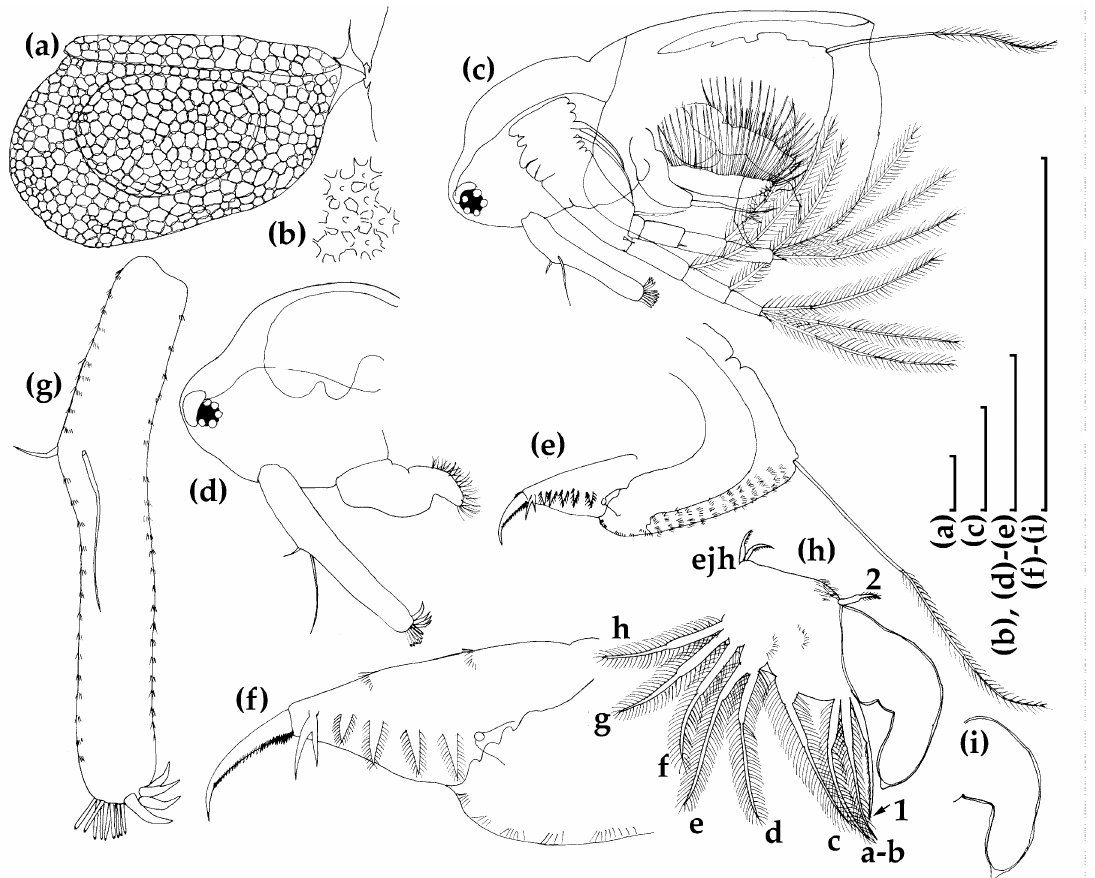
Figure 10. Moina cf. micrura , an ephippium ( a , b ) and an adult male ( c – i ) from Masfoot Dam 1, United Arab Emirates. ( a ) Ephippium, lateral view; ( b ) ornamentation of ephippium with higher magnification; ( c ) male, lateral view; ( d ) head; ( e , f ) postabdomen; ( g ) antenna I; ( h ) thoracic limb I; ( i ) copulatory hook. All scale bars: 0.1 mm. Parthenogenetic female. Body ovoid in lateral view, moderately low for genus Material examined. Two parthenogenetic females from locality 1, coll. 28 October (body height/length = about 0.62), maximum height in middle portion (Figure 7a). Dor- 2019 by S.E.S. Al Neyadi; four parthenogenetic females from locality 1, coll. 21 January 2020 sum of valve somewhat elevated behind head. Shallow dorsolateral depression separates by S.E.S. Al Neyadi; three parthenogenetic females, four ephippial females from locality head from rest of body. Posterodorsal angle prominent, rounded, posteroventral angle broadly rounded. Ventral margin moderately convex. Anterodorsal angle prominent, rounded. Very fine sculpture on valves, forming cells elongated in dorsoventral direc- tion, no integumental hairs on head and valves. Body moderately compressed laterally in anterior view. Head relatively large, with prominent supra-ocular depression and massive com- pound eye (Figure 7b). Ocellus absent. Head pores absent. Labrum with fleshy main body, its ventral margin slightly concave, labral plate densely setulated (Figure 7b). Valve large, broadly ovoid (Figure 7a). Anterior portion of ventral margin provided with moderately long setae covered by tiny setulae (Figure 7c), posterior margin with a row of setulae, grouped in its ventral portion (Figures 7d and 8b – e). Thorax relatively long. Abdomen short. Postabdomen elongated, conically narrowing distally (Figure 7e,f); ventral margin almost straight, with rows of minute setulae. Preanal margin long, convex, gradually passing to anal margin. Preanal and anal portions covered by rows of minute setulae (Figure 7f). Postanal portion conical, both distal margin and dorsodistal angles not ex- pressed. Laterally postanal portion of postabdomen bearing a row of 8 – 10 large, trian- gular, plumose teeth. Anteriormost tooth bidentate, with branches unequal in length.